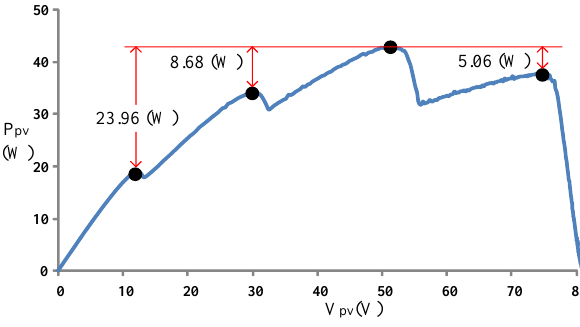
Figure 22. Analysis on the P–V characteristic curve of Case 3. Table 7. Comparison of the test results of the four cases .